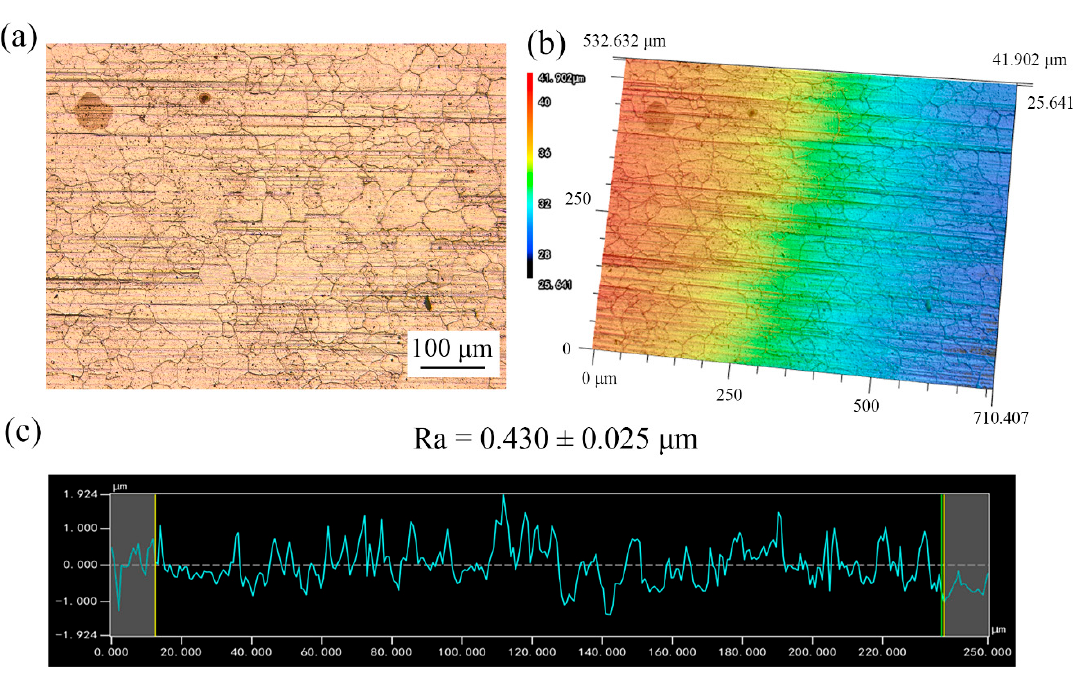
Figure 5. Surface topography of copper foils annealed at 650 °C without LPS. ( a ) 2D surface topography; ( b ) 3D surface topography; ( c ) roughness curve.